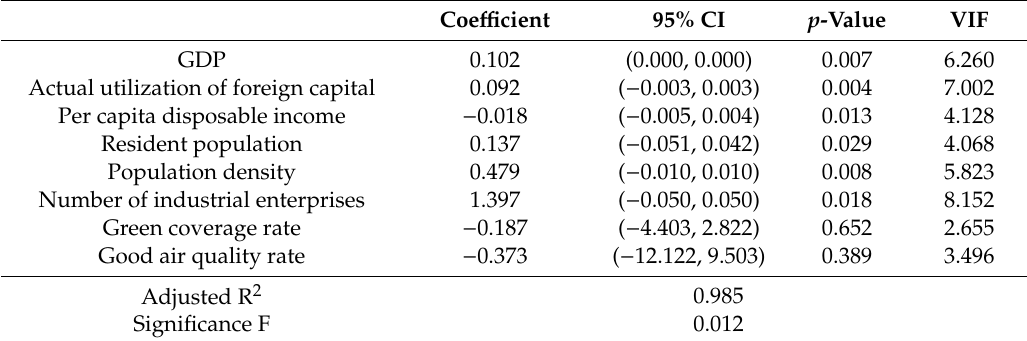
Table 3. Multiple linear regression results.